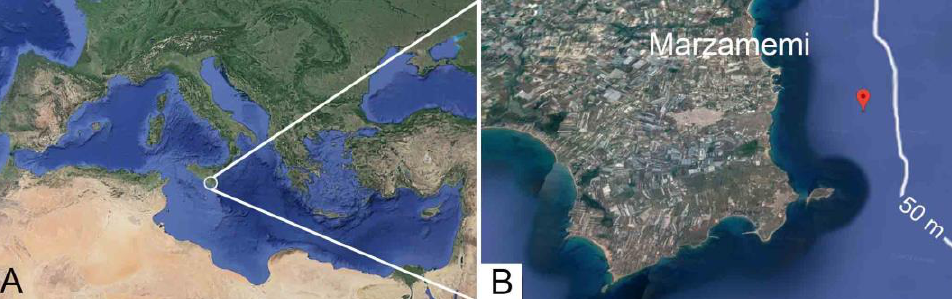
Figure 1. Location of the sampling site in the coralligenous bottoms in the western Ionian Sea: ( A ) within the Mediterranean Sea, and ( B ) right ESE of the Marzamemi village.